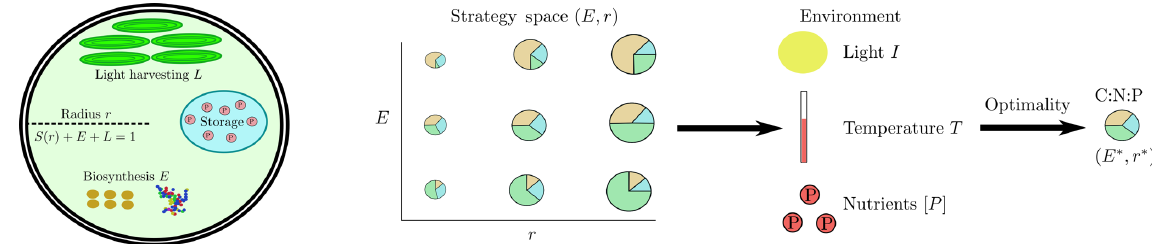
Figure 3. Diagram of physiological model. Phytoplankton strategies are represented in a two-dimensional strategy space ( E,r ). Each strategy is assigned a fitness in each environment using physiological principles, and the strategy with the highest fitness is selected to represent the local population. The stoichiometry of cellular components is used to calculate the stoichiometry of the functional pools in the